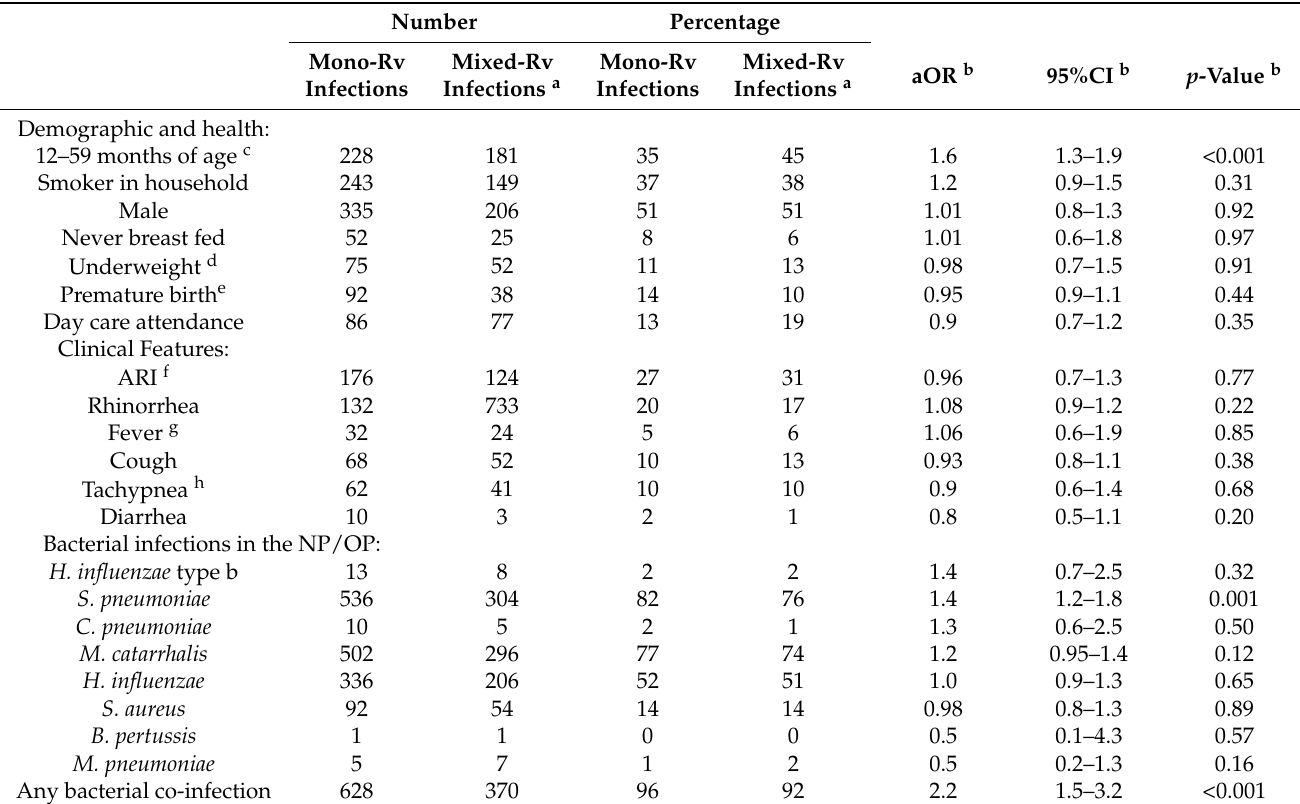
Table 2. Demographic and Clinical Characteristics of Community Controls with rhinovirus as the Only Detected Virus (Mono-RV; N = 656) and Those with rhinovirus Plus at Least One Other Respiratory Virus Detected (Mixed-RV; N = 400), All PERCH